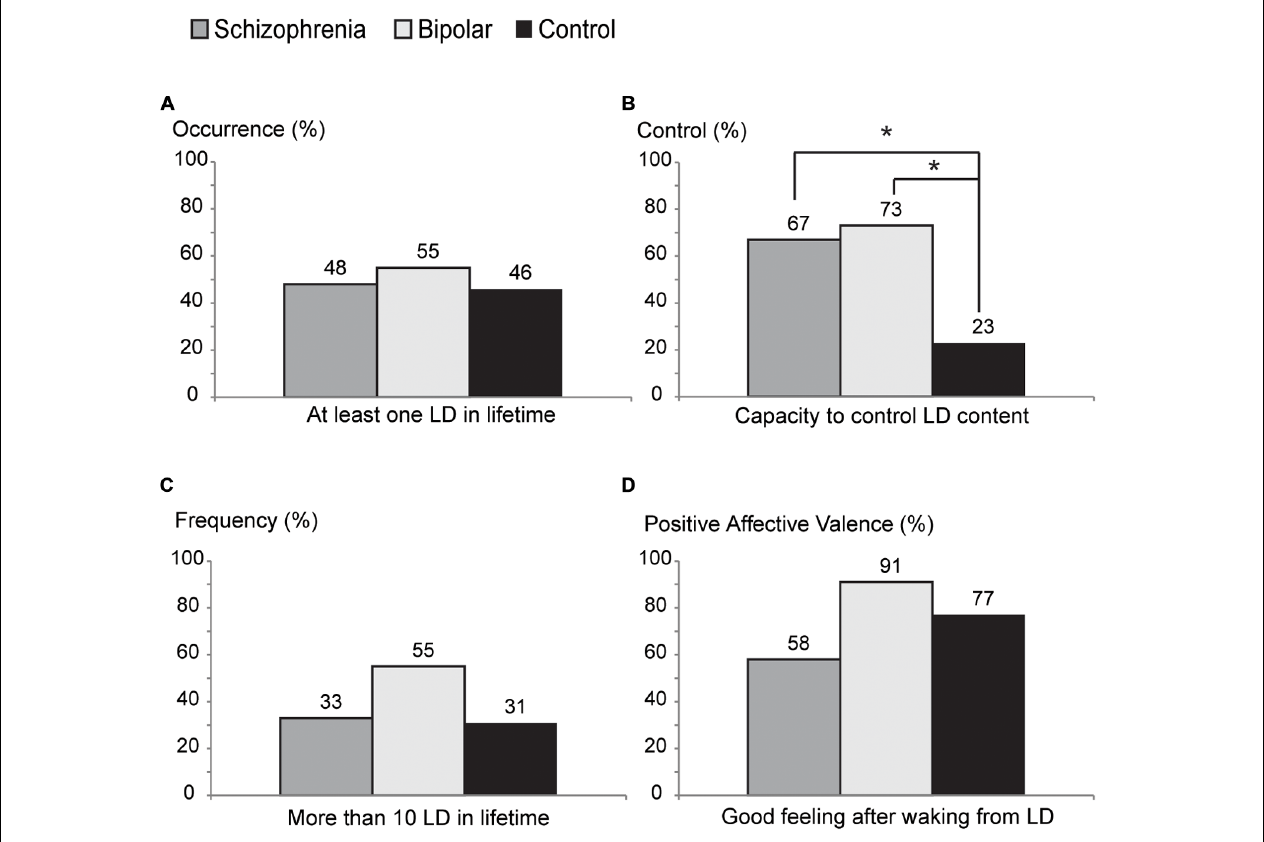
FIGURE 1 | Characteristics of lucid dream reports in schizophrenia (S), bipolar (B), and control (C) groups. (A) Percentage of each group reporting occurrence of lucid dreaming at least once in a lifetime. (B) Percentage of the ability to control their dreams: psychotic groups report control ability more frequently than control group (S vs. C: p = 0.0283, B vs. C: p = 0.0150). (C) Percentage of high frequency of lucid dreams (more than 10 lucid dreams in a lifetime). (D) Percentage of positive affective valence (good feeling after wake up from a lucid dream) ( ∗ p <